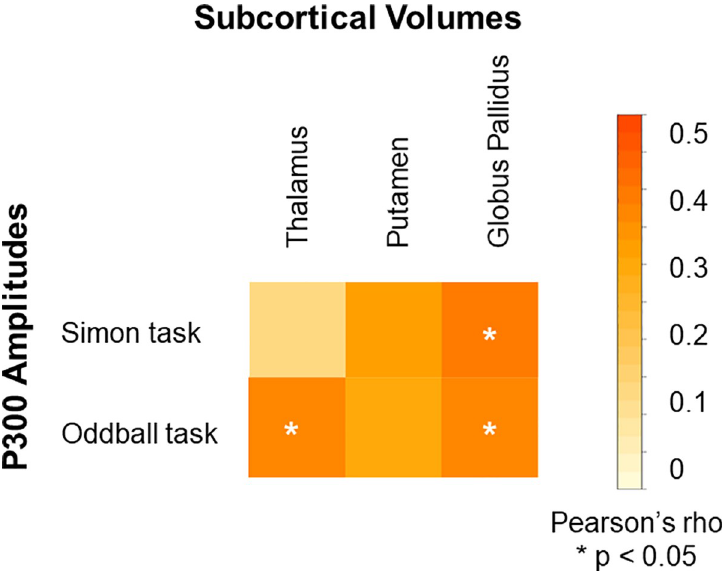
Fig 6. Relationships between volumes of selected subcortical nuclei and P300 amplitudes in the Simon and oddball tasks. Data are from the 27 participants with usable EEG data in both tasks and structural MRI. Asterisks indicate significant correlations (uncorrected). The scale indicates Pearson’s r